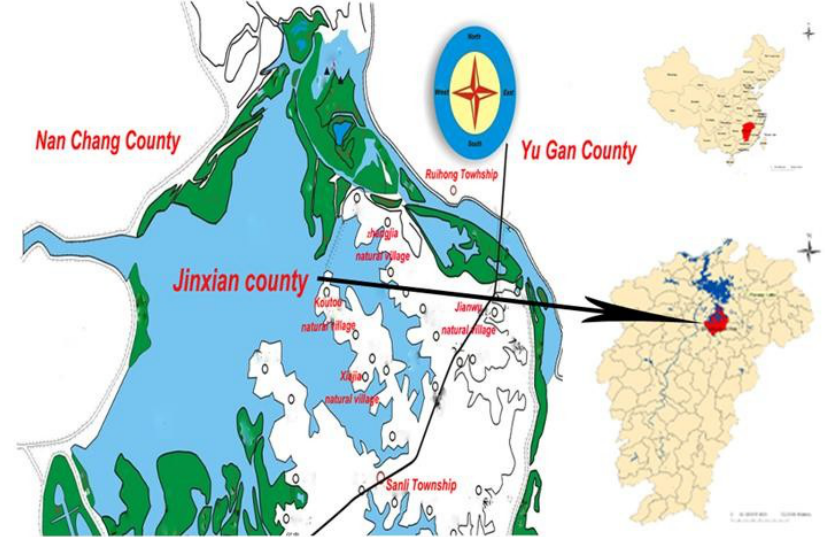
Figure 1. The geographical distribution of the cases villages (Zhangjia and Jianwu villages) and the control villages (Koutou and Xiajia village) in Sanli Township of Jinxian County, Jiangxi Province in China.